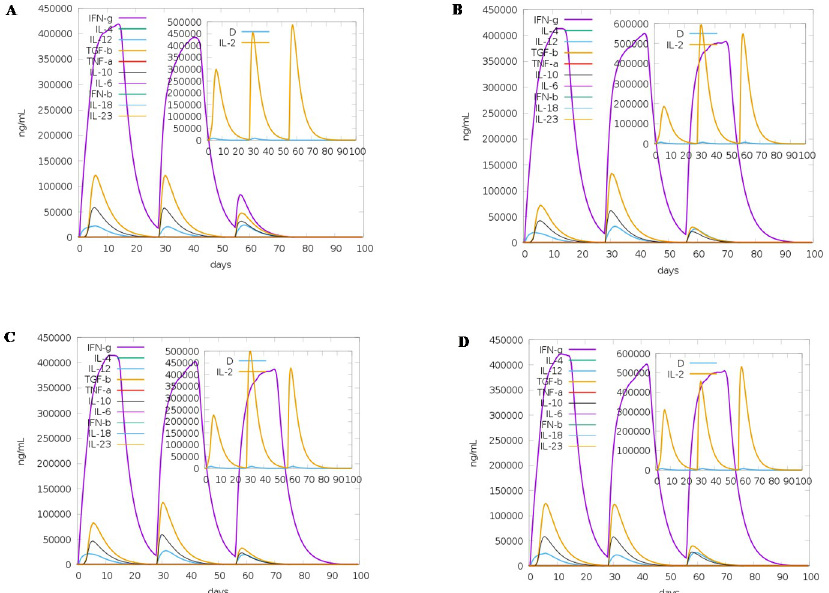
Fig 7. In silico immune simulation of multi-epitope vaccine constructs of SARS-CoV-2. C-ImmSim simulation of the cytokine levels induced by three injections administered four weeks apart. The main plot shows cytokine levels after the injections. The inset plot shows IL-2 levels with the Simpson index (D), which is indicated by the dotted line, is a measure of diversity. Increase in D over time indicates the emergence of different epitope-specific dominant clones of T cells. The smaller the D value, the lower the diversity. (a) The receptor-binding domain (RBD) of the spike (S) protein (B- and T-cell epitopes); (b) The S protein (B- and T-cell epitopes); (c) The structural protein construct (B- and T-cell epitopes of S, N, M, and E proteins); (d) The chimeric construct of S and N proteins (B- and T-cell epitopes of S and N